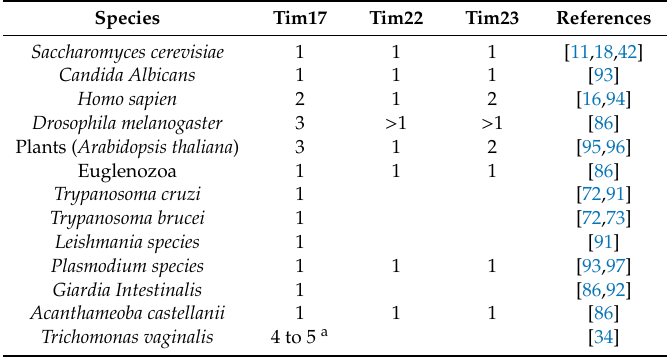
Table 3. Number of copies of Tim17, Tim22, and Tim23 protein isoforms in di ff erent